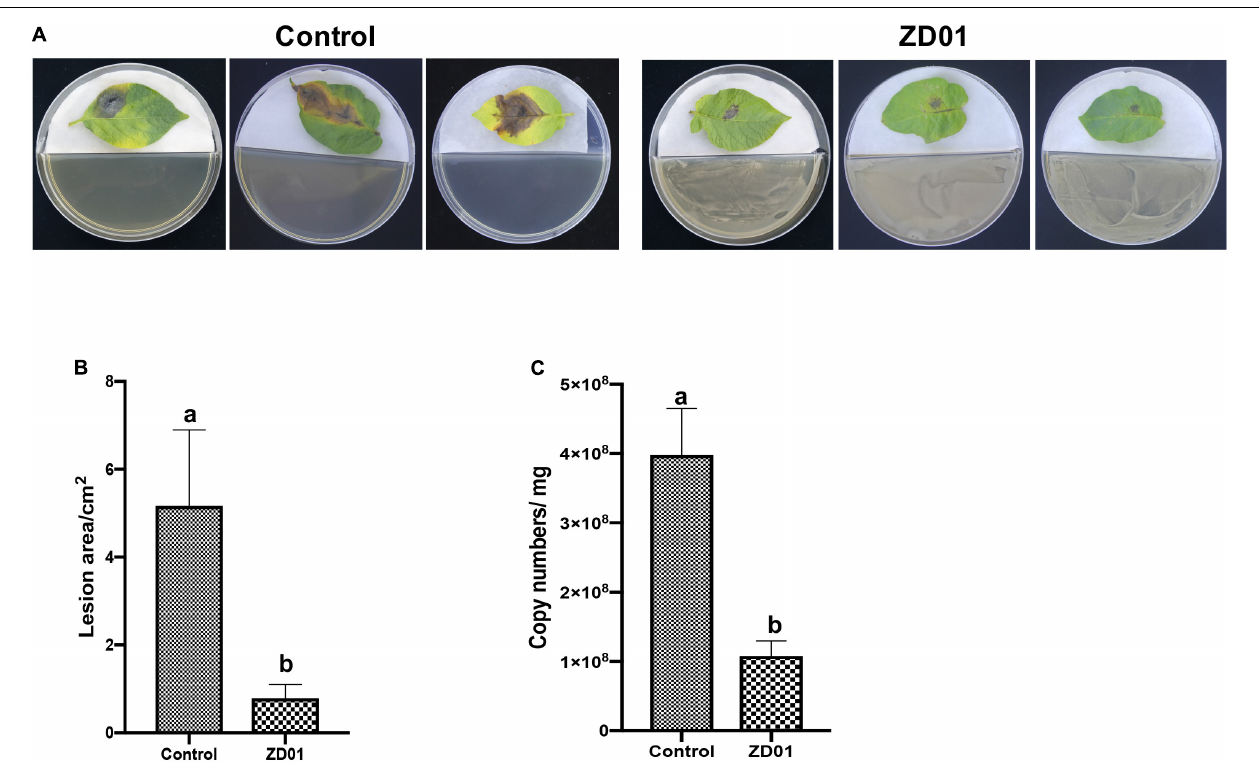
FIGURE 3 | Antagonistic effects of VOCs produced by strain ZD01 against A. solani on potato leaf. (A) Effect of VOCs produced by ZD01 on development of early blight symptoms on Potato leaf. (B) Lesion areas of potato leaf with or without the treatment by ZD01 volatiles. (C) A. solani copy numbers per leaf were detected in potato leaf. Control represents A. solani without treatment of ZD01 VOCs; ZD01 represents A. solani with treatment of ZD01 VOCs. Data presented are the mean ± s.d. ( n = 3). The same letter on the bars for each column indicates no significant difference according to a LSD test at P =